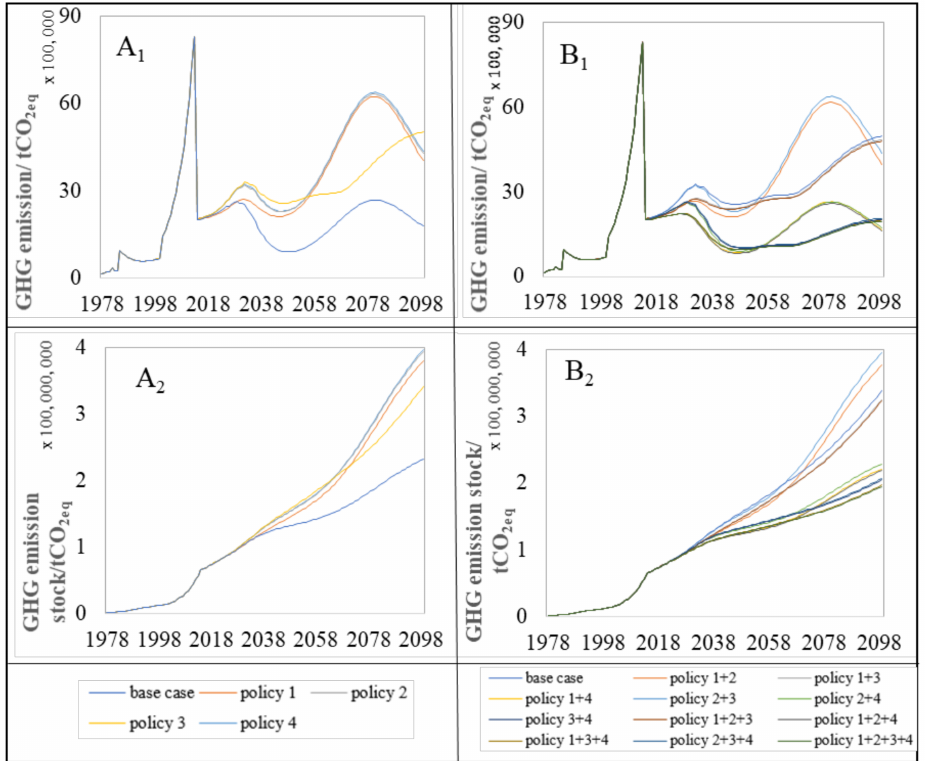
Figure 9. Trend of annual and stock of GHG emission for base case and proposed policy measures. A 1 and B 1 represent the impact trend of single policy and complex policy on GHG emission, respec- tively. A 2 and B 2 are the impact trend of single policy and complex policy on GHG emission stock,